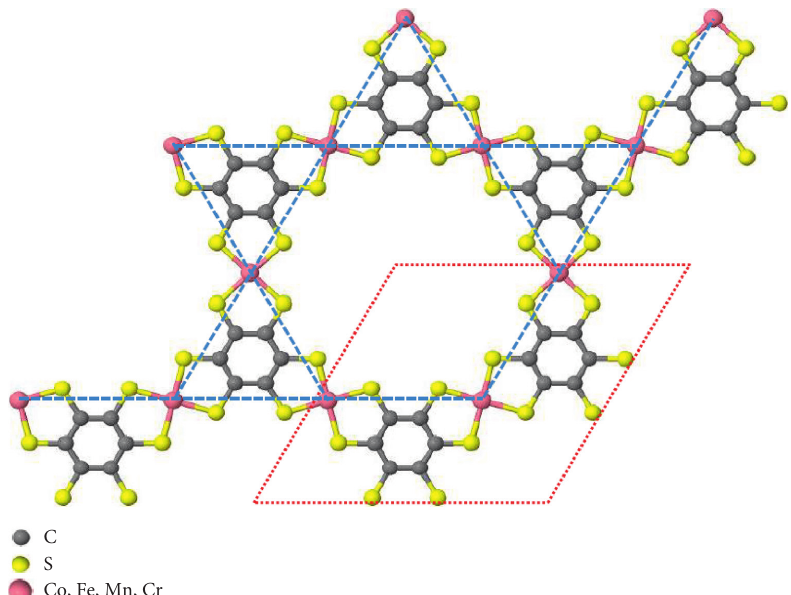
Figure 2: ( 2 × 2 ) supercell of planar MBHT